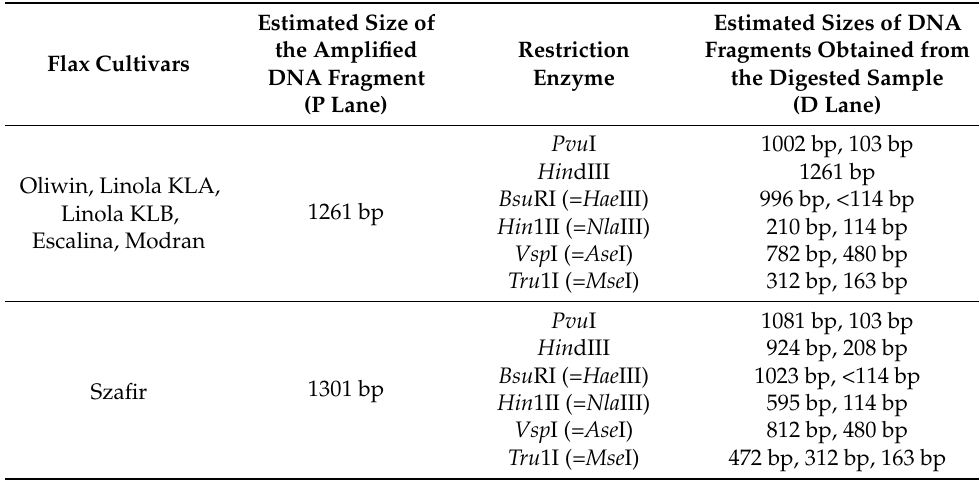
Table 3. Band patterns of CAPS markers obtained using the described primers and six various restriction enzymes.